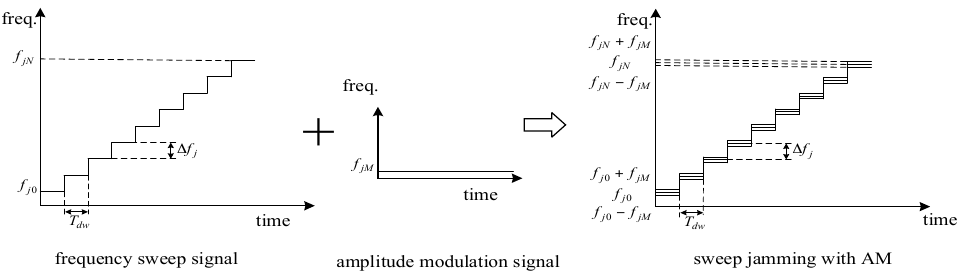
Figure 2. Block diagram of time–frequency analysis for the sweep jamming signal with AM.